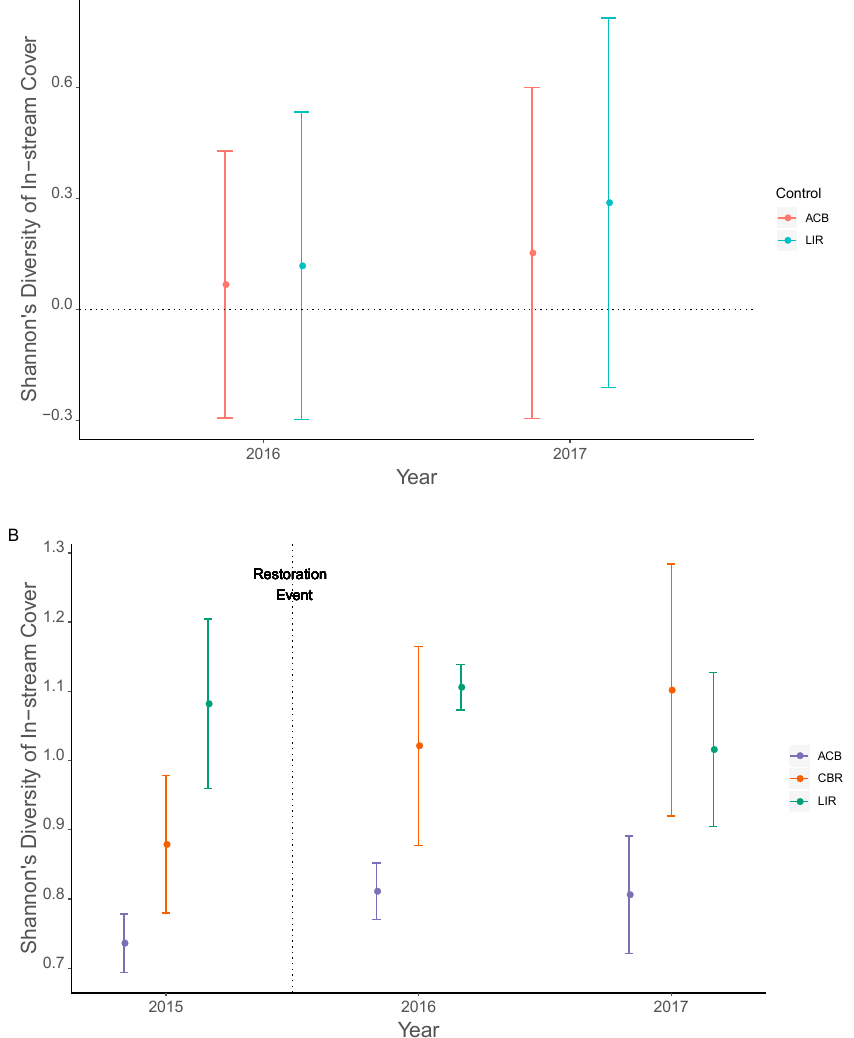
Figure 4. Shannon’s diversity of in-stream cover (H cov ) as given by BACI effect size ( A ) and actual values with standard error ( B ). No significant differences are observed in effect size, with confidence interval ranges overlapping zero ( A ) while pairwise Welch’s t -tests were not significant ( α = 0.008) between CBR and other treatments within each year ( B ). ACB = active cranberry bog, CBR = cranberry bog restoration, LIR = least impacted reference. All statistical comparisons are listed in Supplemental Table S4A and Supplemental Table S5B.